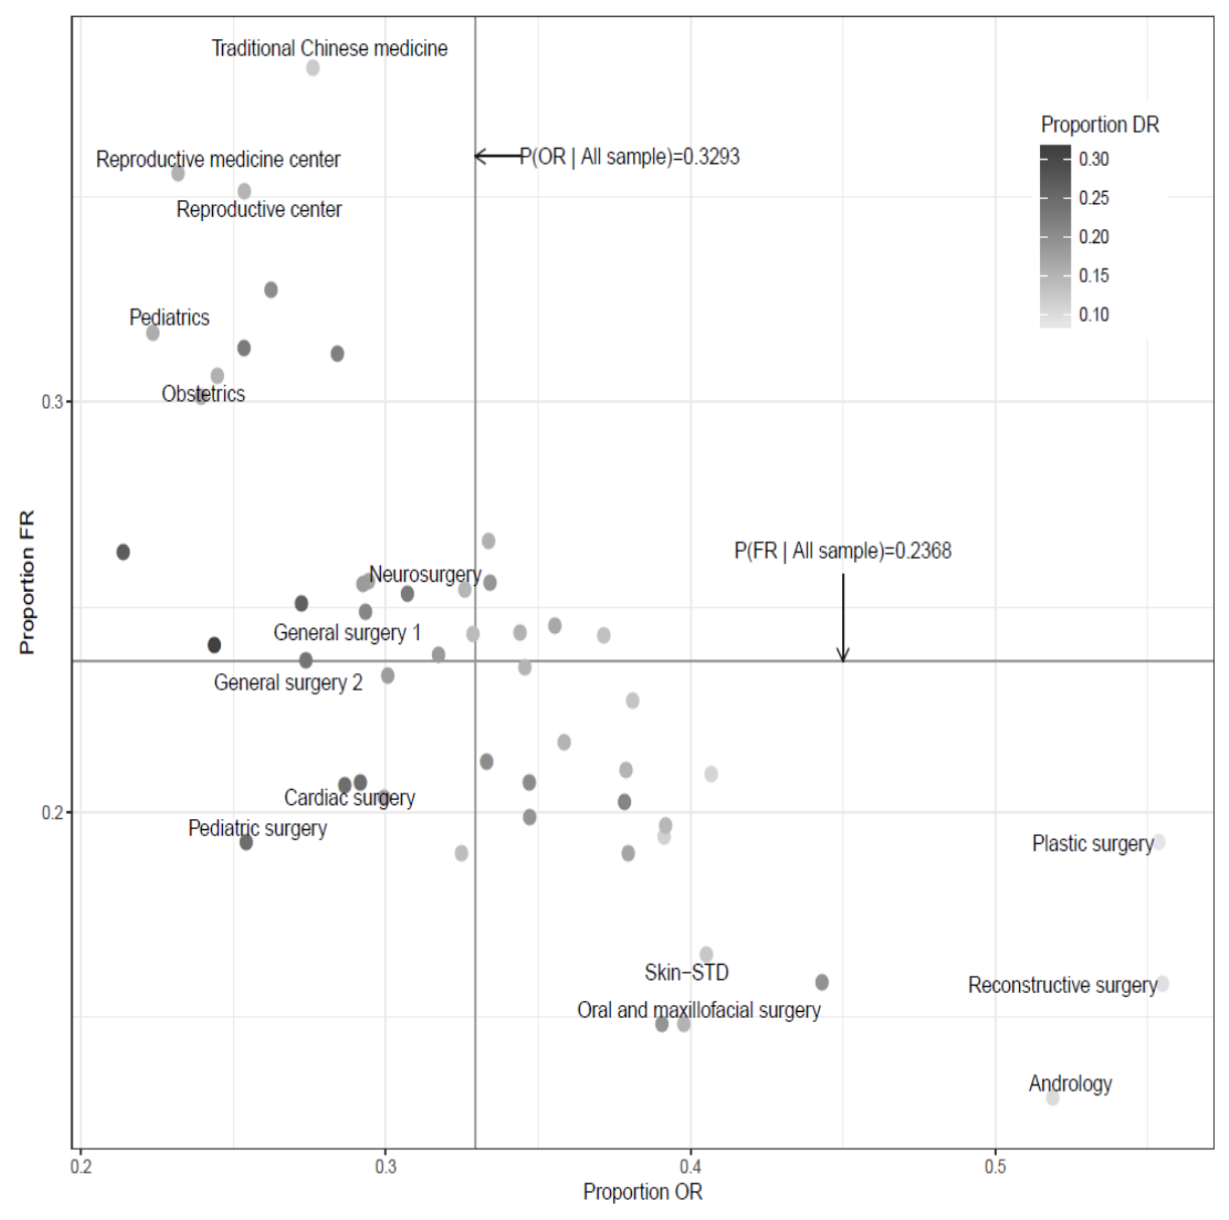
Figure 7. Proportions in the use of information sources for different medical specialties. DR: doctor recommendations; FR: family and friend recommendations; OR: online reviews; STD: sexually transmitted